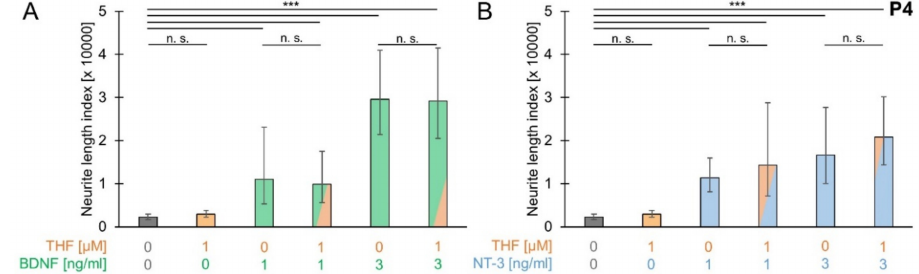
Figure 5. THF e ffi cacy with low concentrations of BDNF and NT-3. SGEs from P4 cochleae were cultured in medium supplemented with 1 µ M 7,8,3 (cid:48) -trihydroxyflavone (THF) and / or BDNF ( A ) or NT-3 ( B ) or in medium devoid of neurotrophic